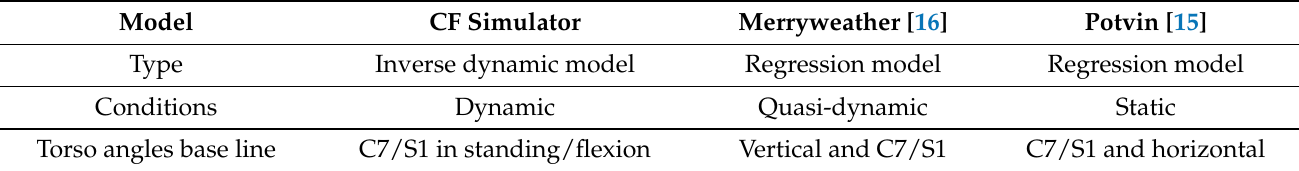
Table 1. Characteristics of the three CF